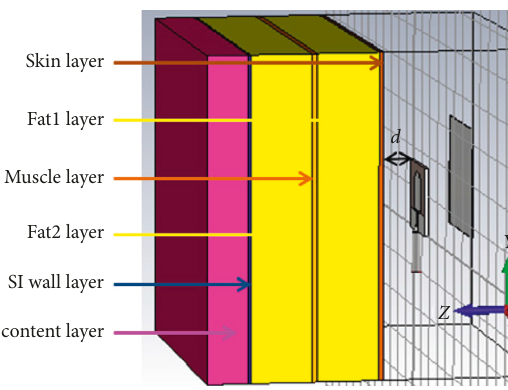
Figure 14: Designed reflector-backed antenna next to the multilayer model.